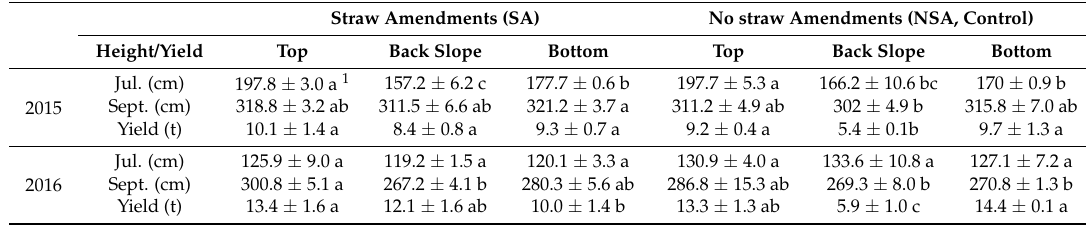
Table 5. Mean crop height and yield in the SA and NSA treatments in 2015 and 2016 ( n = 3). Straw Amendments (SA) No straw Amendments (NSA,